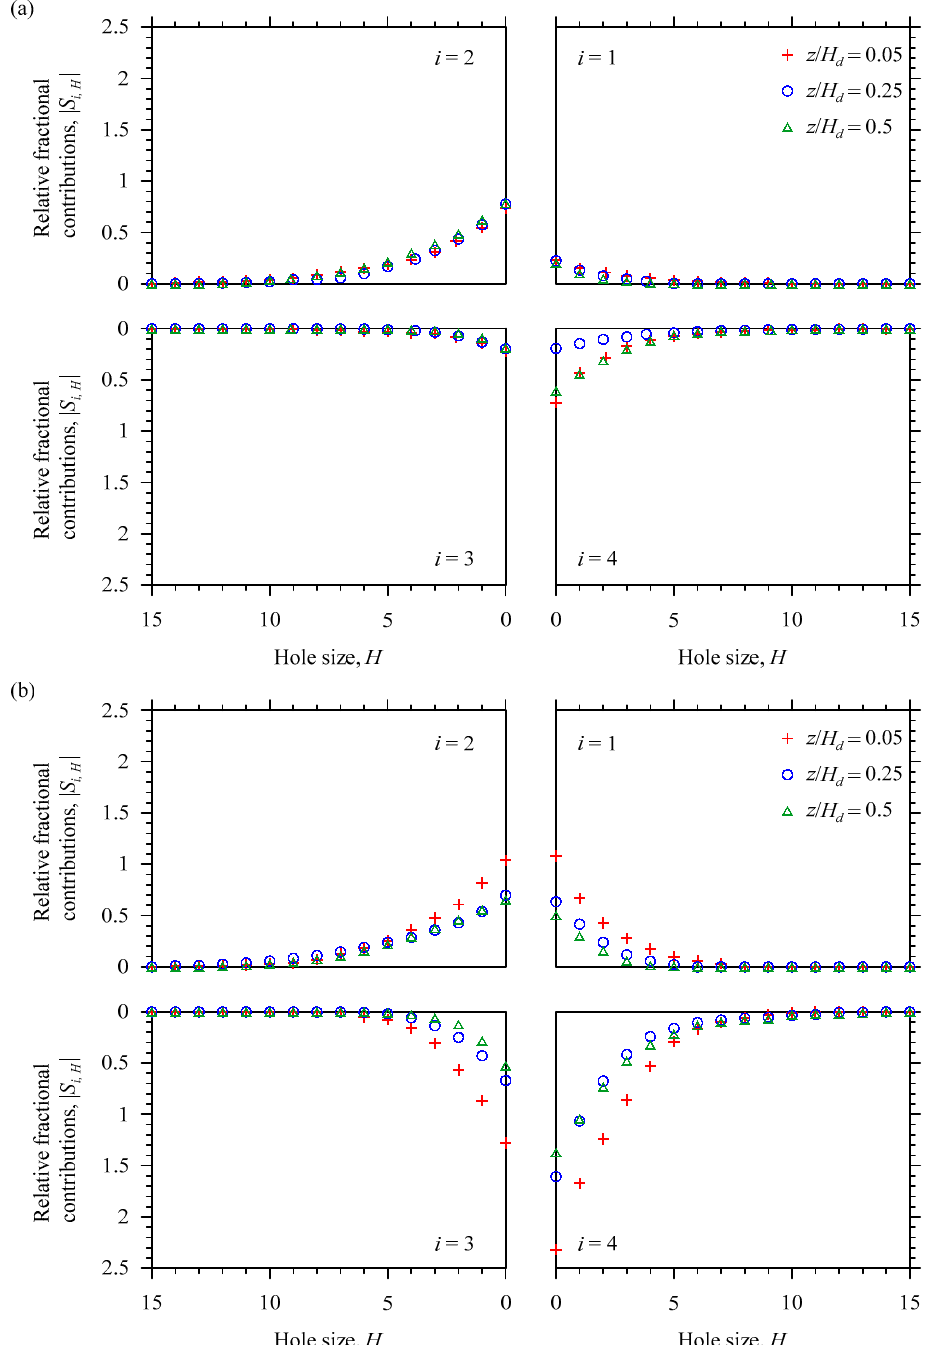
Figure 11. Relative fractional contributions | S i , H | as a function of hole size H in Run 1 at relative streamwise distances (a) x / L d = –0.5 and (b) x / L d = 1 for relative vertical distances z / H d = 0.05, 0.25 and 0.5.